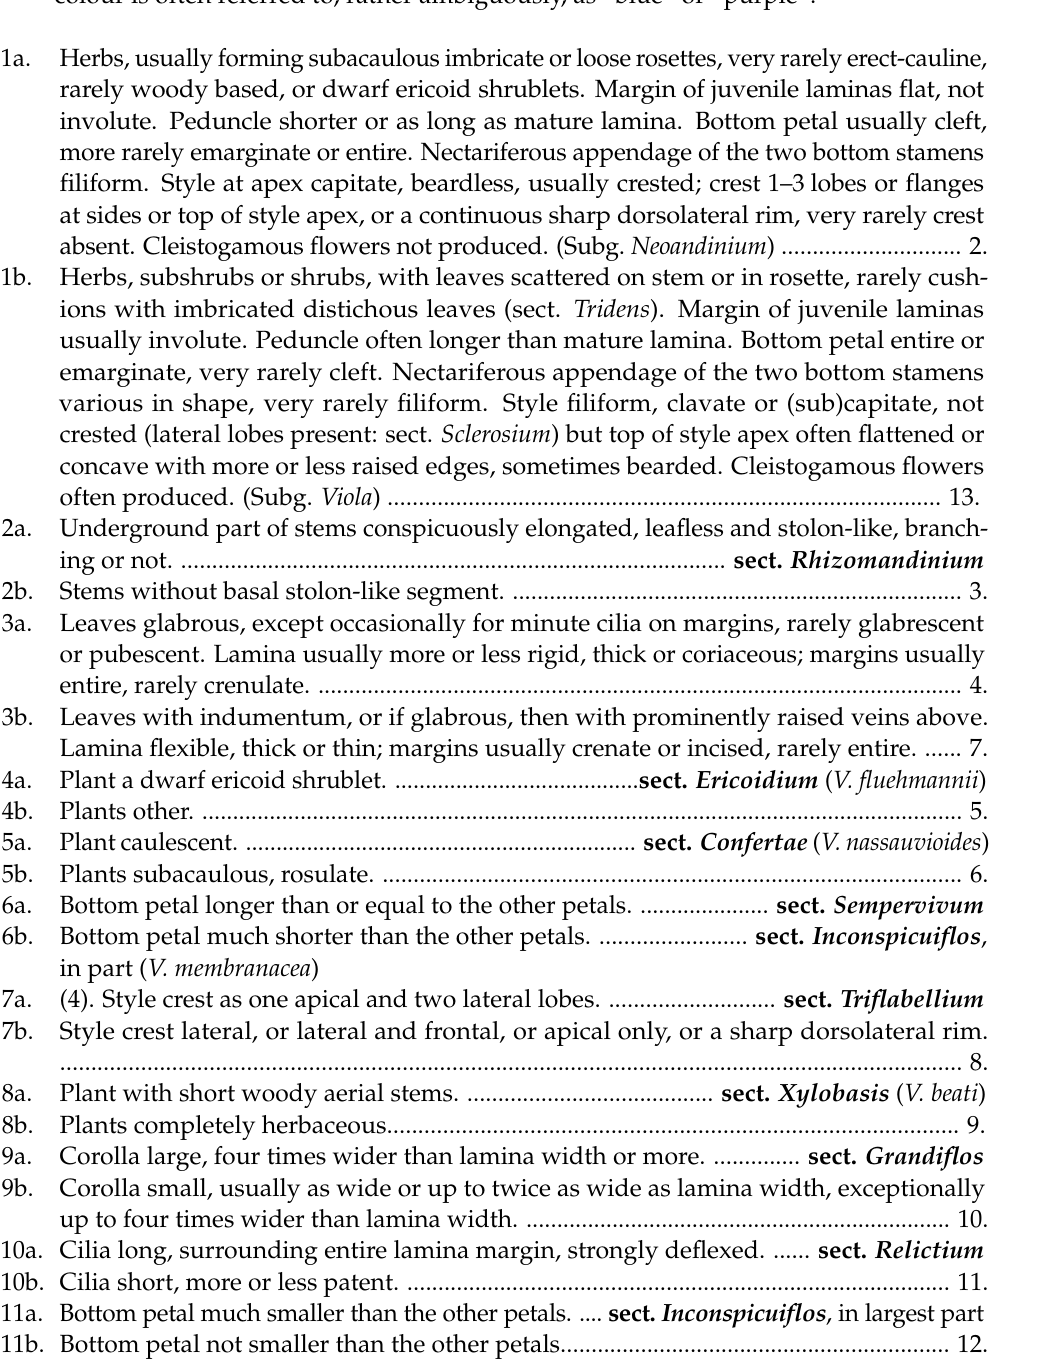
Herbs, subshrubs or shrubs, with leaves scattered on stem or in rosette, rarely cush- ions with imbricated distichous leaves (sect. Tridens ). Margin of juvenile laminas usually involute. Peduncle often longer than mature lamina. Bottom petal entire or emarginate, very rarely cleft. Nectariferous appendage of the two bottom stamens various in shape, very rarely filiform. Style filiform, clavate or (sub)capitate, not crested (lateral lobes present: sect. Sclerosium ) but top of style apex often flattened